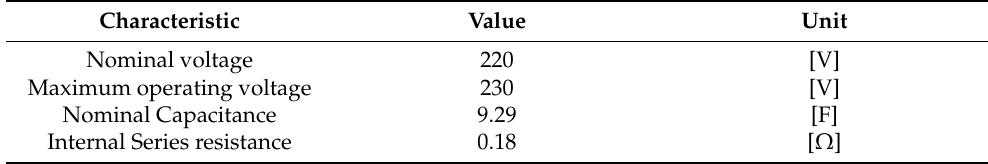
Table 1. Supercapacitor parameters.